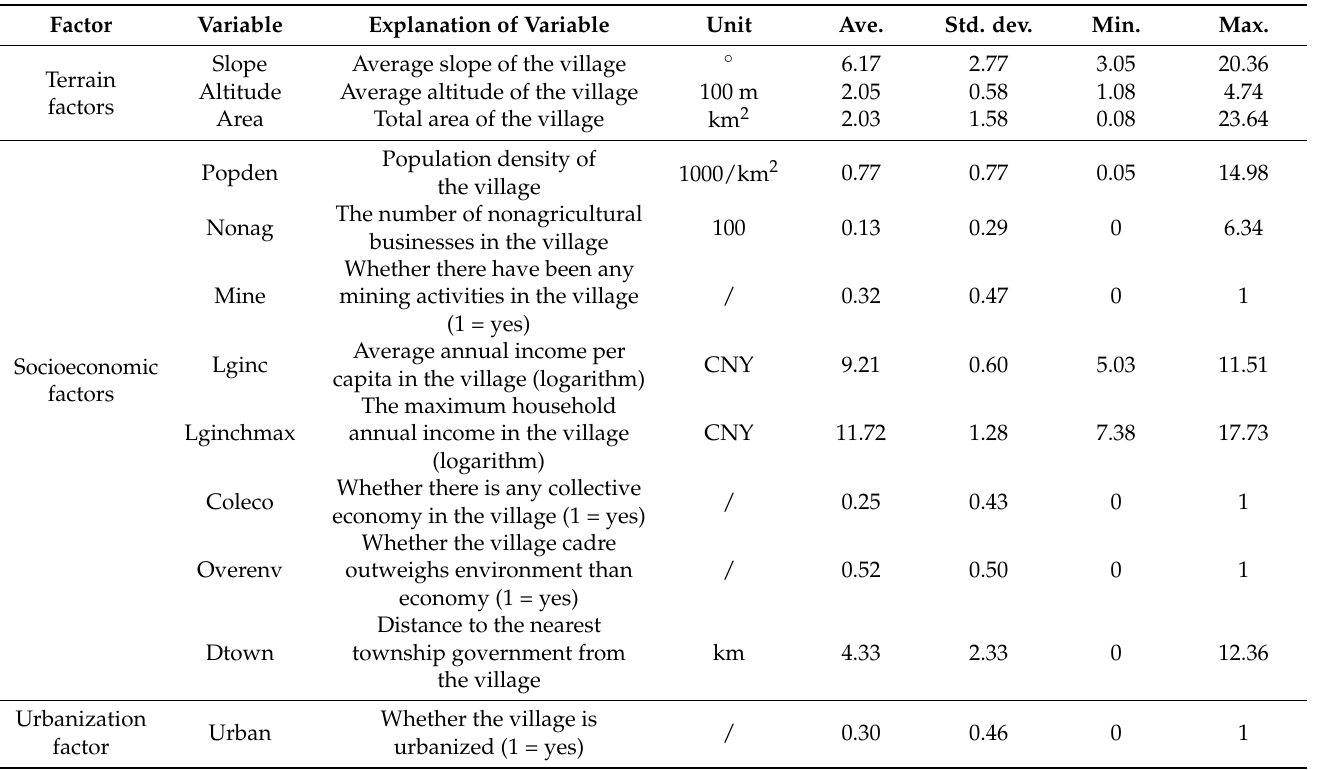
Table 4. Descriptive statistics of independent